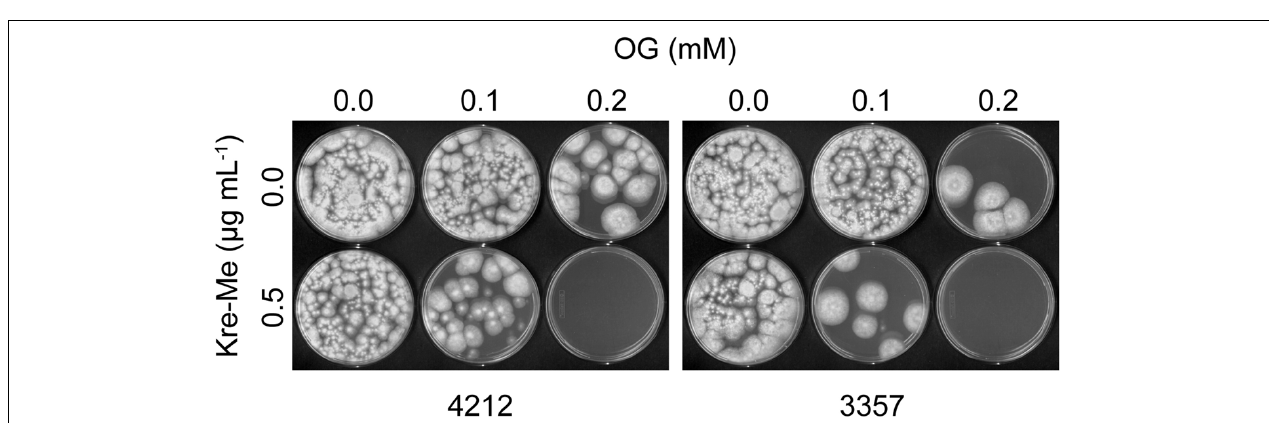
to the chemosensitization than the WT (AF293), indicating that the antioxidant system of Aspergillus plays an important role for fungal tolerance to the chemosensitization. On the other hand, co-application of Kre-Me with BHAM (conventional antifungal chemosensitizer disrupting AOX) at the same concentrations resulted in survival of A. fumigatus strains. Similar result was observed in A. fumigatus mpkC (cid:2) mutant (Figure data not shown).